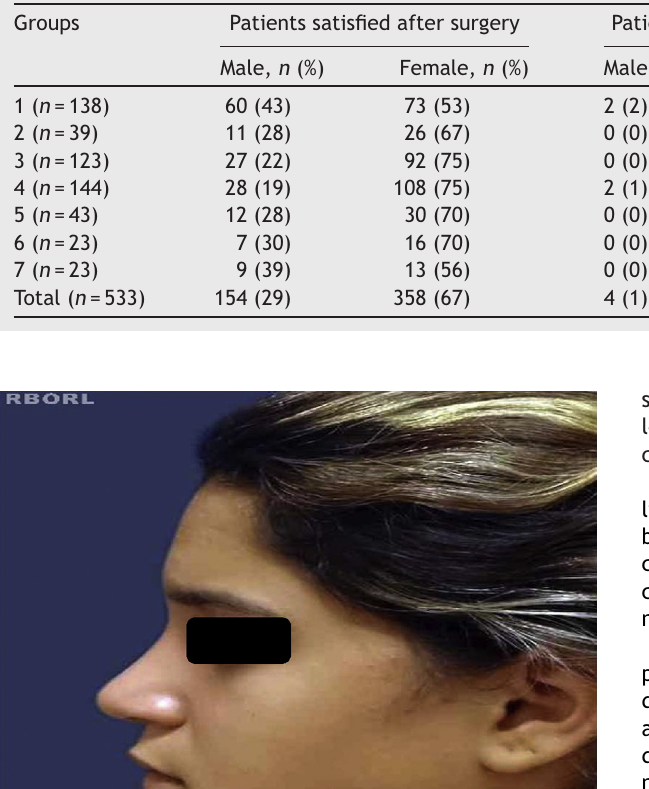
Table 4 Distribution of patients according to gender, in each group, in relation to the satisfaction with the surgical procedure outcome.